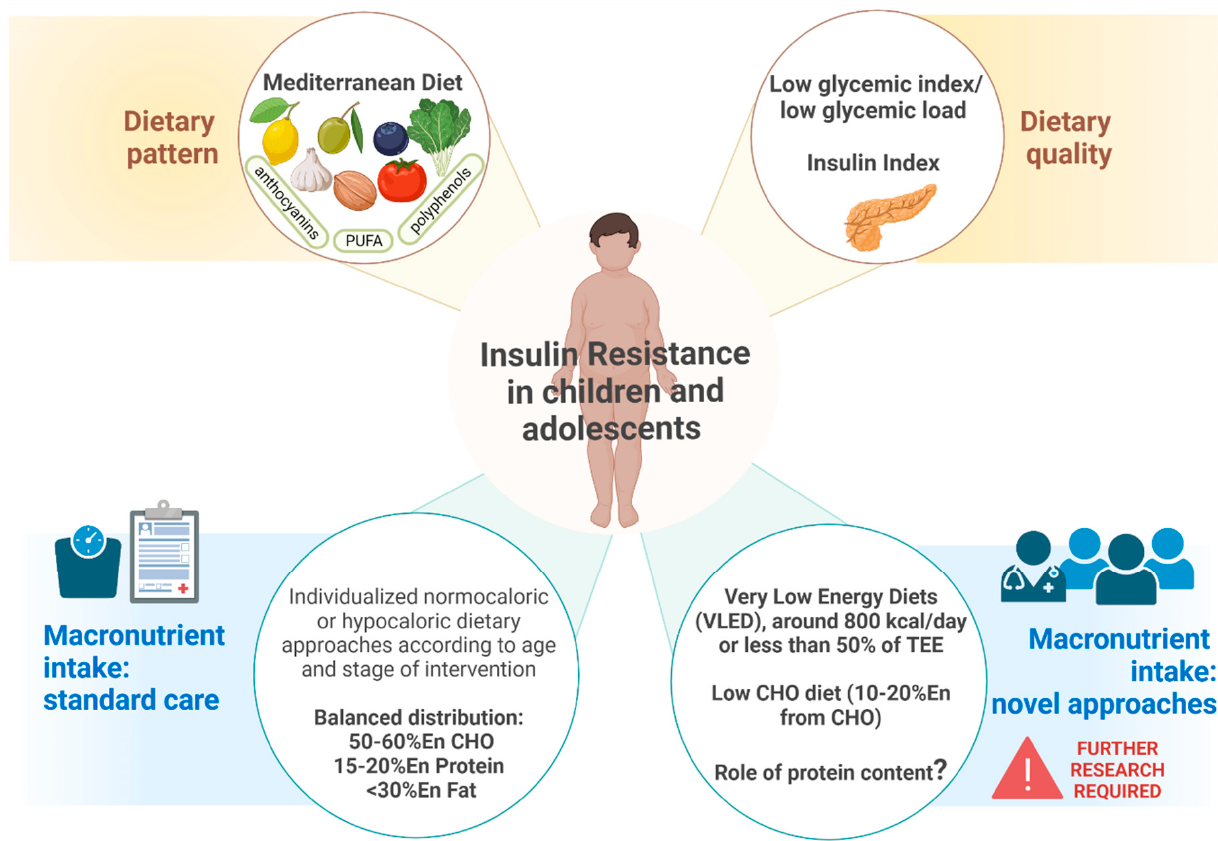
Figure 2. Key impacts of the dietary approach on insulin resistance (created using BioRender).